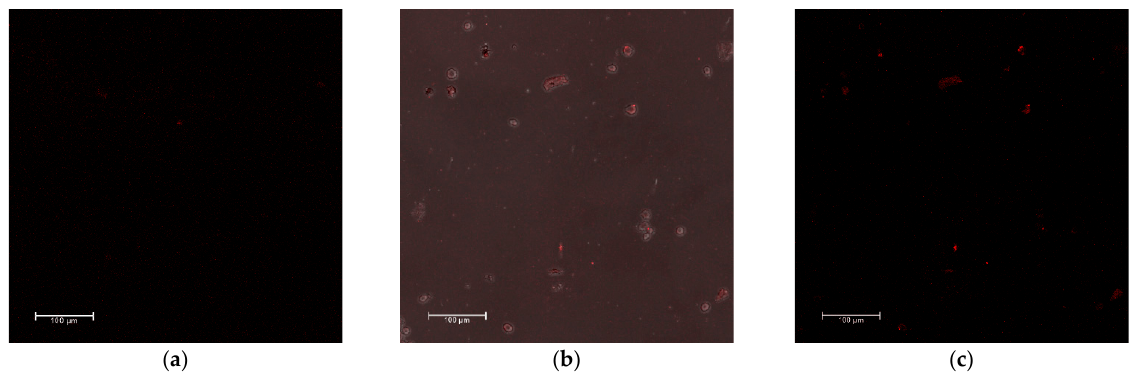
Figure 8. Detection of AF647 using a 633 nm excitation laser with confocal microscopy at 20× magnification for ( a ) control 9LGS cell population and cells exposed to 50ug/mL gold suspension for 24 h; ( b ). with bright field; ( c ) without bright field. Cells were washed and suspended in PBS (hence they are not adherent). The red areas of AF647 fluorescence are clearly located inside the cells.